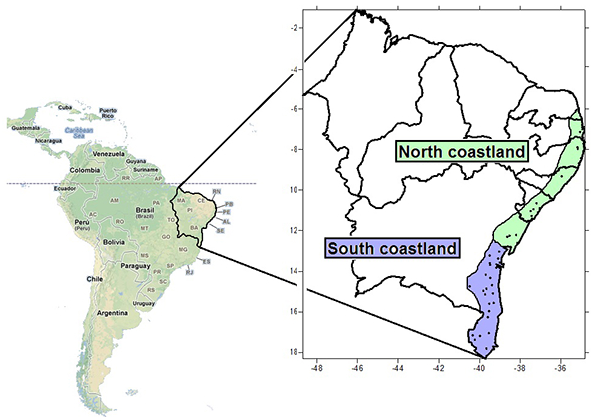
Fig. 1. The rain gauge spatial distribution (black dots) over the NEB